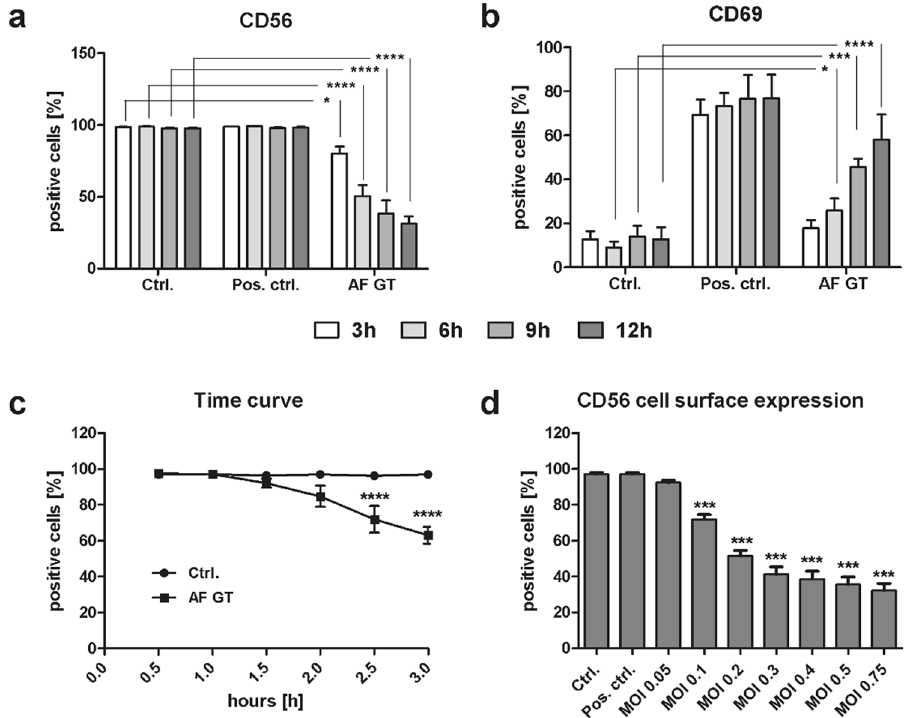
Figure 1. Reduction in CD56 positivity after fungal contact. NK cells were treated with 500 U/ml IL-15 and IL-2 (Pos. Ctrl.), with A . fumigatus germ tubes (AF GT, MOI 0.5) or left untreated (Ctrl.) for different periods of time. Flow cytometry was performed to analyze ( a ) CD56 expression (n = 4), ( b ) CD69 expression (n = 5), ( c ) time dependent down-regulation of CD56 (n = 5) and ( d ) CD56 expression after treatment with different MOIs of A . fumigatus germ tubes (AF GT, n = 3). NK cells were incubated for 3, 6, 9 and 12 h to determine ( a ) CD56 and ( b ) CD69 expression. To determine the time dependent down-regulation of CD56 NK cells were incubated for 0.5, 1, 1.5, 2, 2.5 and 3 h ( c ). To assess the effect of different fungal MOIs NK cells were incubated for 6 h ( d ). NK cells were defined as NKp46 + CD3 − . Data are represented as mean + SEM. Significant differences were are marked with an asterisk ( * p < 0.05, *** p < 0.005, **** p <